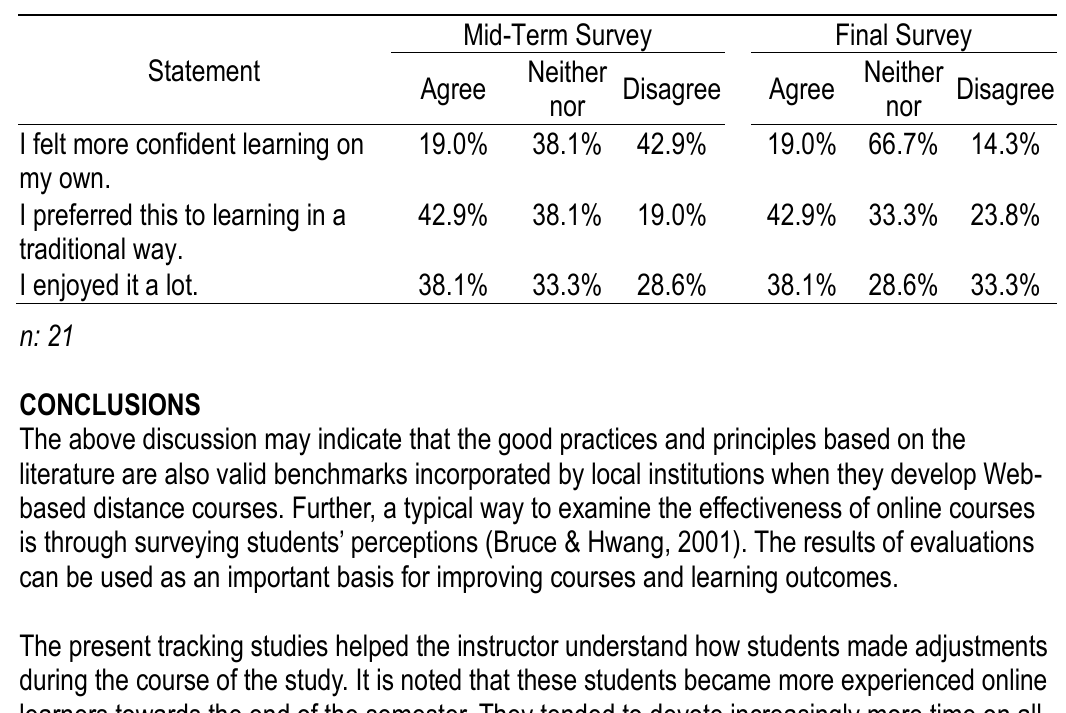
Table 9. Evaluation of online